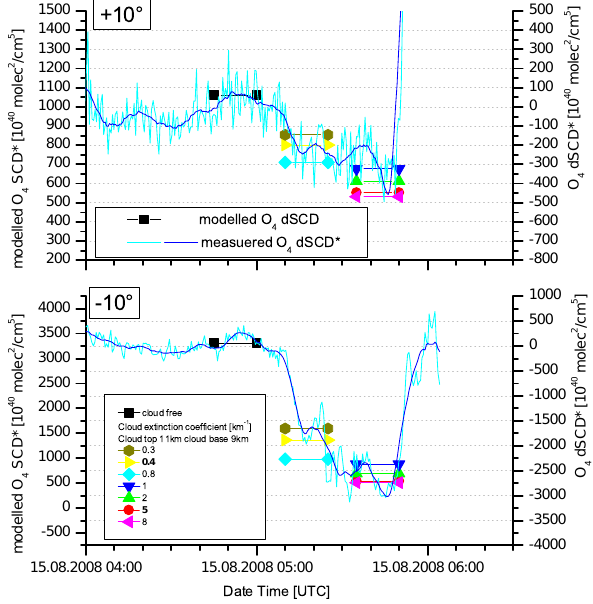
Fig. 6. Observed (Fig. 4) and modelled O 4 column densities us- ing the same scale range 1 = 1300 and 5000 × 10 40 molec 2 /cm 5 for the upward and downward directed telescope respectively. The best agreement between measurement and simulations is obtained for a total cloud optical thickness of 0.8 ( k =0.4km − 1 ) for the first cloud and 10 ( k =5km − 1 ) for the second